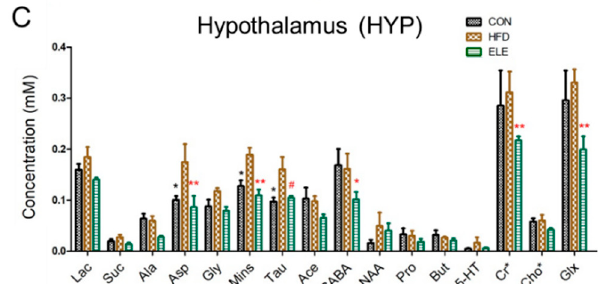
Figure 1. Comparison of mouse brain metabolites quantitated by 1 H NMR spectroscopy. ( A–C ) Concentrations of cerebral metabolites in mouse prefrontal cortex (PFC) ( A ), hippocampus (HIP) ( B ), and hypothalamus (HYP) ( C ). CON, normal diet; HFD, high-fat diet; and ELE, HFD-induced obese mice under treatment with β -elemene. Cr*, Cr + PCr; Cho*, Cho + PCho; and Glx, Glu + Gln. The results are shown as the mean ± SEM ( n = 4). # p < 0.1; * p < 0.05; ** p < 0.01; *** p < 0.001 vs. HFD group (assessed using two-way ANOVA followed by Dunnett’s multiple comparisons, the black color of * # means the differences between the CON and HFD and the red color of * # means the differences between the HFD and ELE).